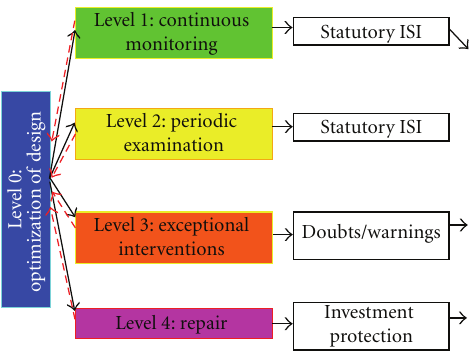
Figure 1: ISI&R approach for future French